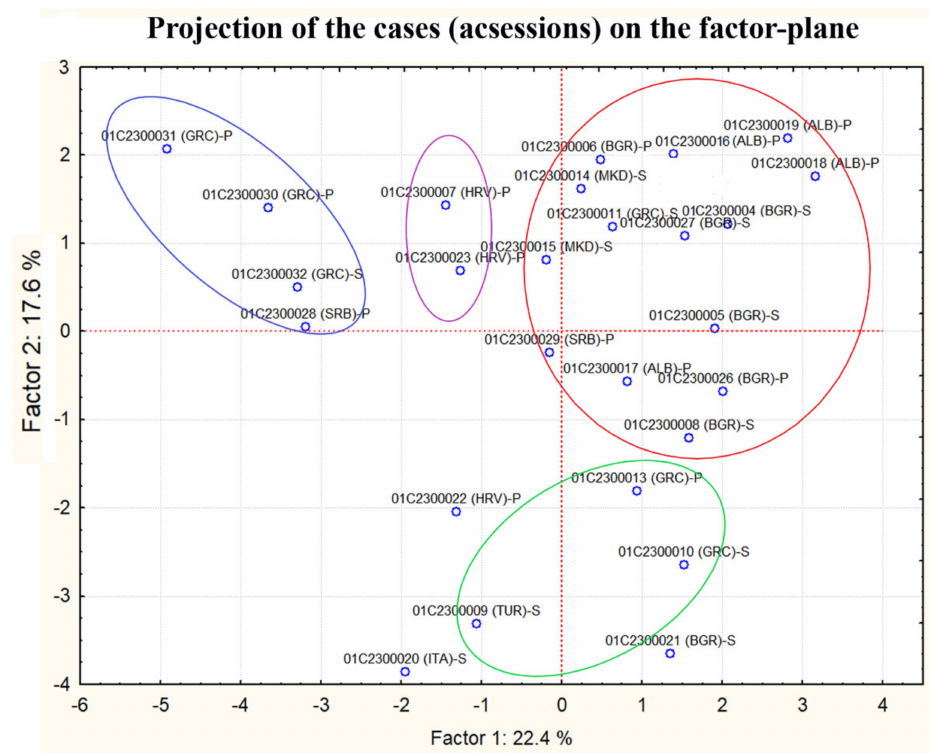
Figure 2. Principal component scores for collection of different Dasypyrum genotypes based on their morphological description (cyan-North Balkan, beige-Central Balkan, green-Southern Balkan,